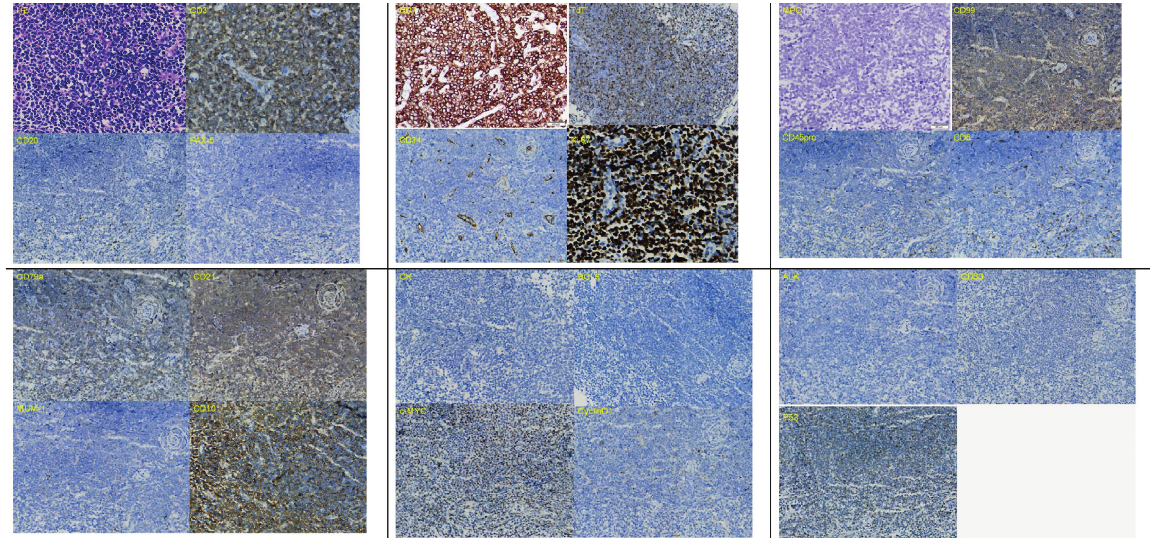
Figure 2: Results of mediastinum mass